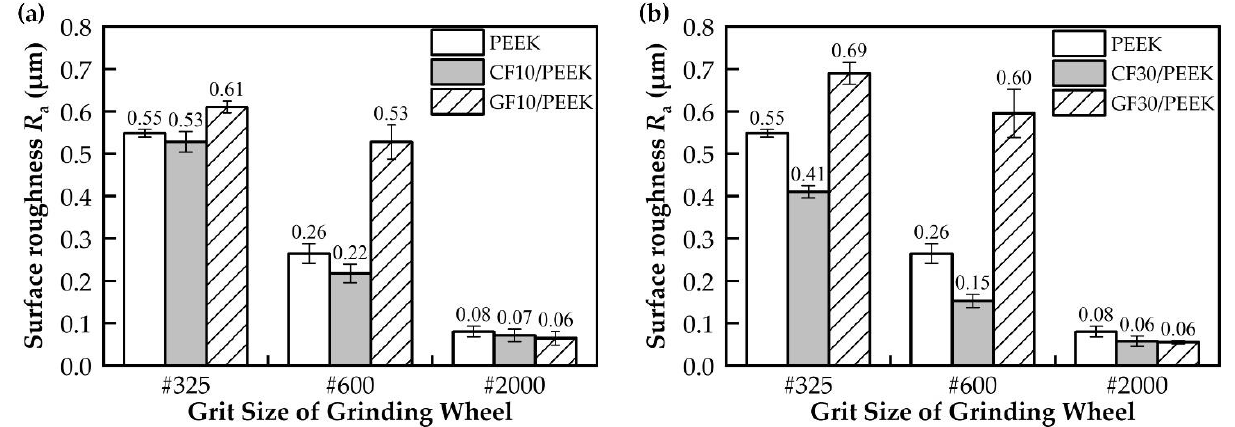
Figure 4. Comparison of surface roughness results for different fiber mass fractions: ( a ) the surface roughness of the pure PEEK, CF10/PEEK and CF30/PEEK; ( b ) the surface roughness of the pure PEEK, GF10/PEEK and GF30/PEEK.